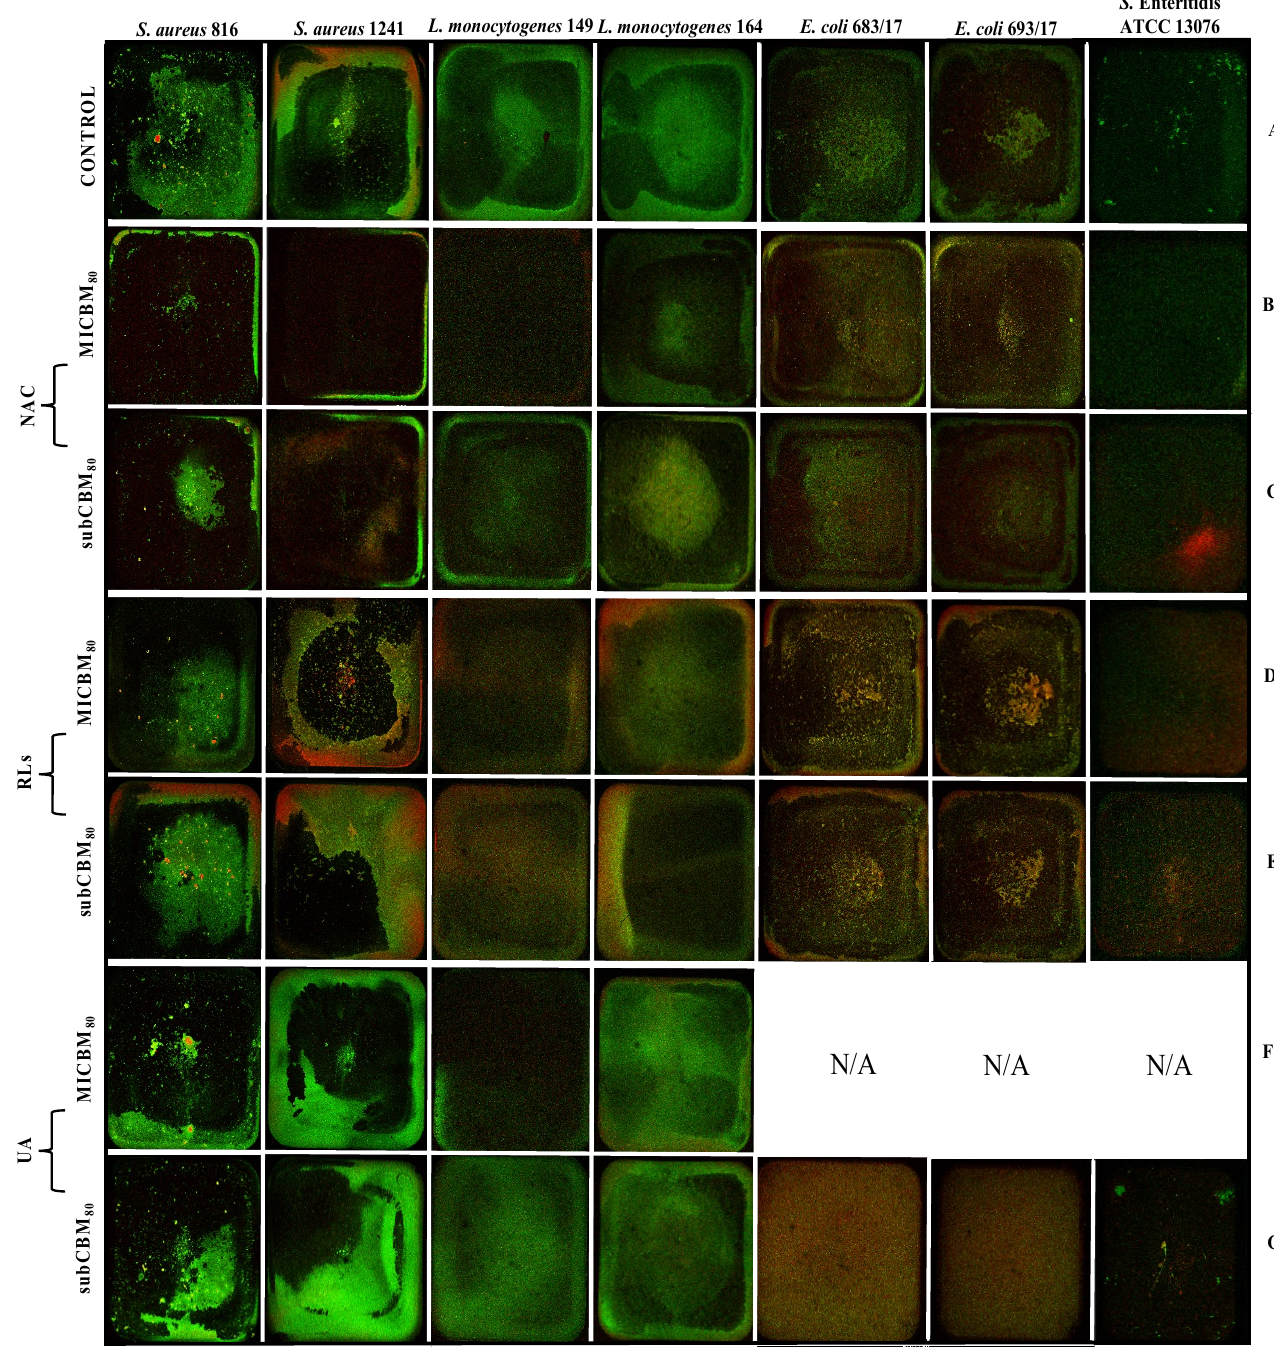
Figure 2. Representative projections of biofilm mass at the bottom of the microtiter wells for Staphylococcus aureus 816 and 1241, Listeria monocytogenes 149 and 164, E. coli 683/17 and 693/17, and Salmonella Enteritidis ATCC 13,076 after 24 h of treatment with the respective antimicrobial compounds. ( A ): positive control; ( B , C ): N -Acetyl- L -cysteine (NAC); ( D , E ): rhamnolipids (RLs); ( F , G ): usnic acid (UA). Prior to imaging, microtiter wells were stained with LIVE/DEAD ® BacLight™ Bacterial Viability Kit distinguishing live cells (green) and membrane-compromised cells (red). Images represent the surface of the well 7.4 × 7.4 mm 2 . For some strains, the minimum inhibitory and subinhibitory concentrations could not be established; thus, they were not involved in the analysis. N/A marks concentration was not applied.